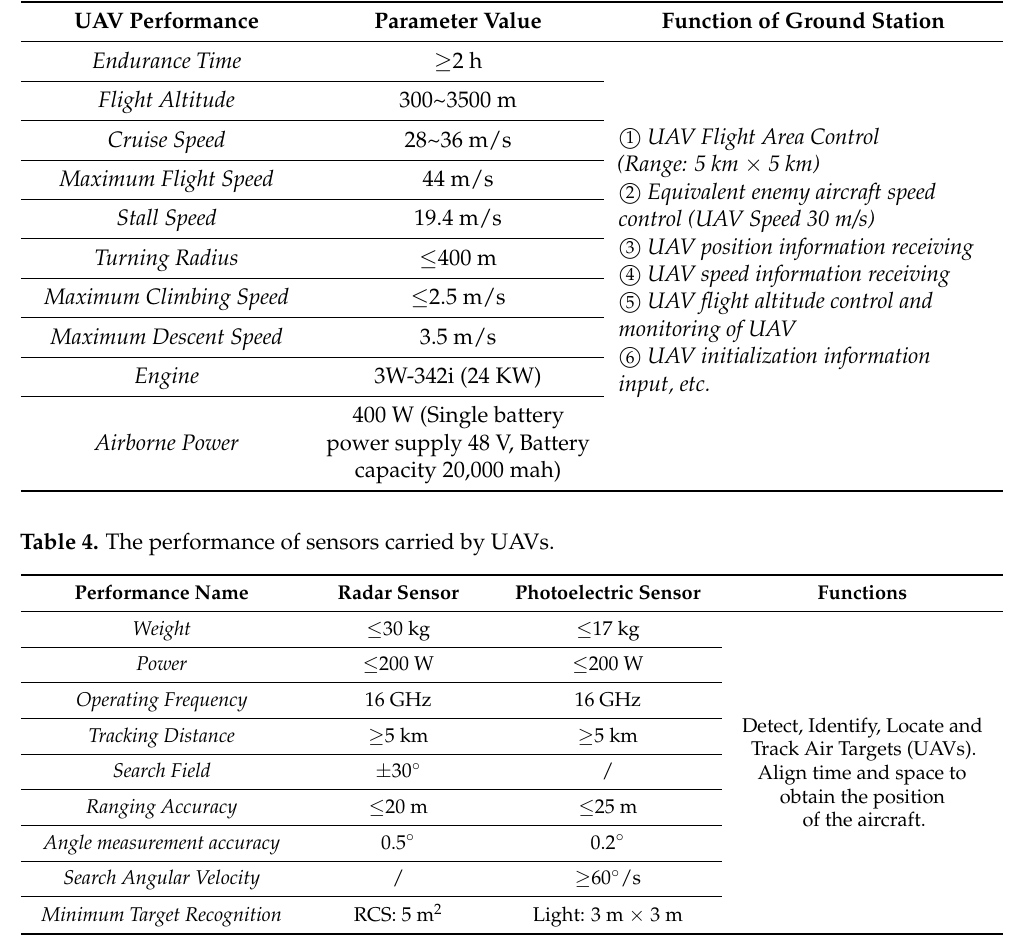
Table 3. The performance of UAV and ground station equipment.